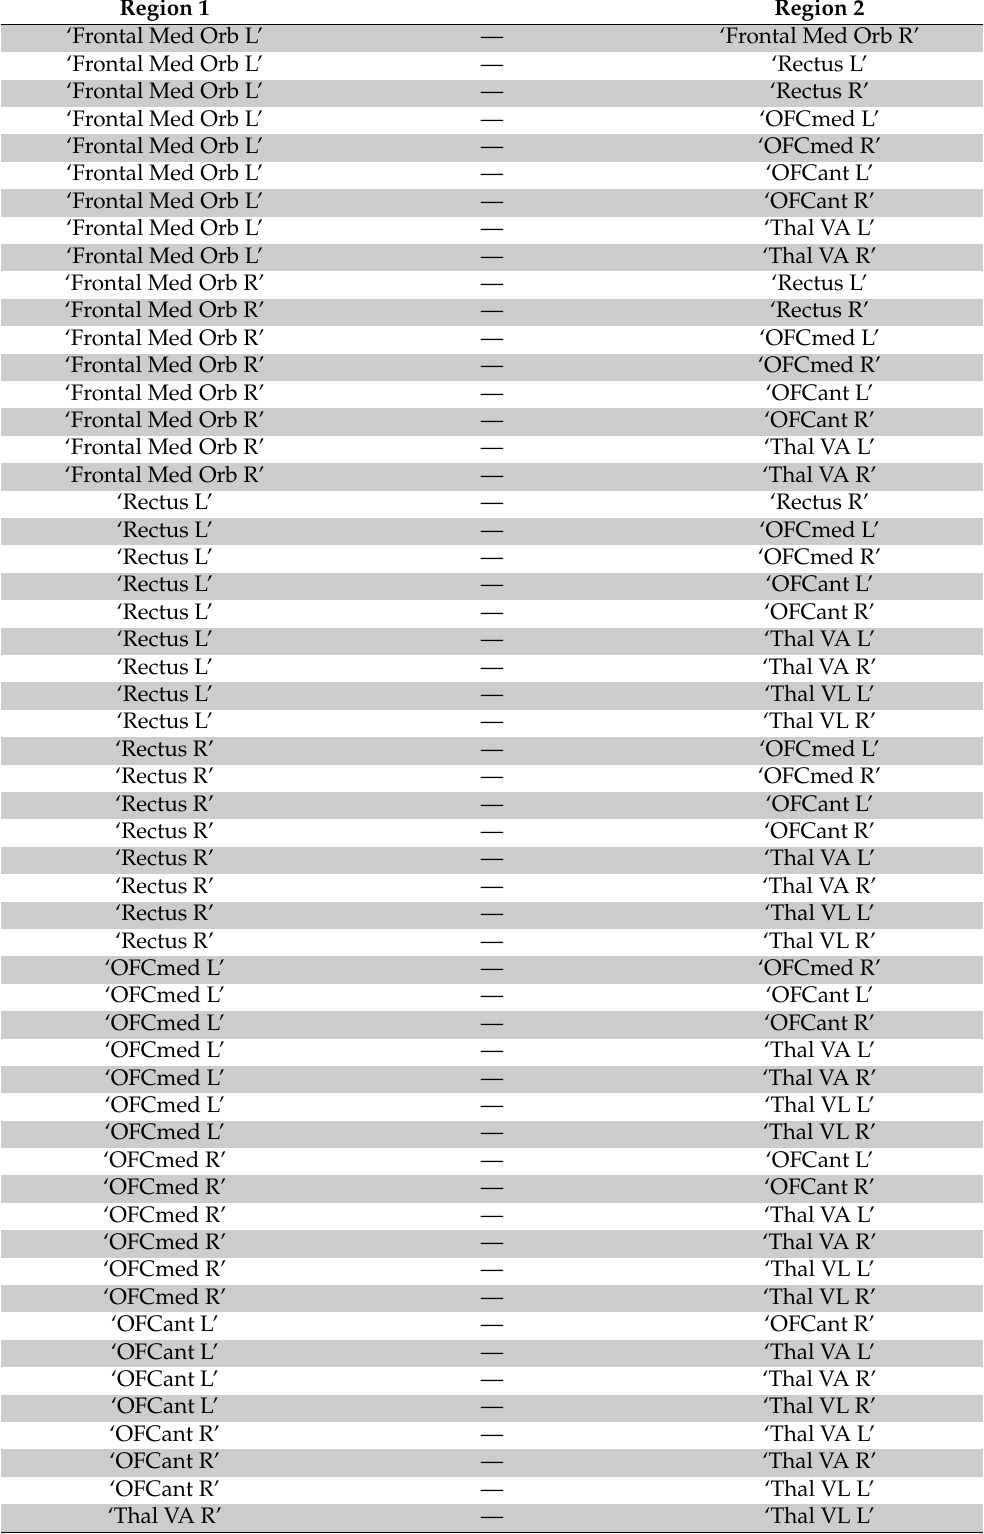
Table A2. List of significant (found with the FDR method) between negative clusters nodes (See Figure 3) for the node centrality